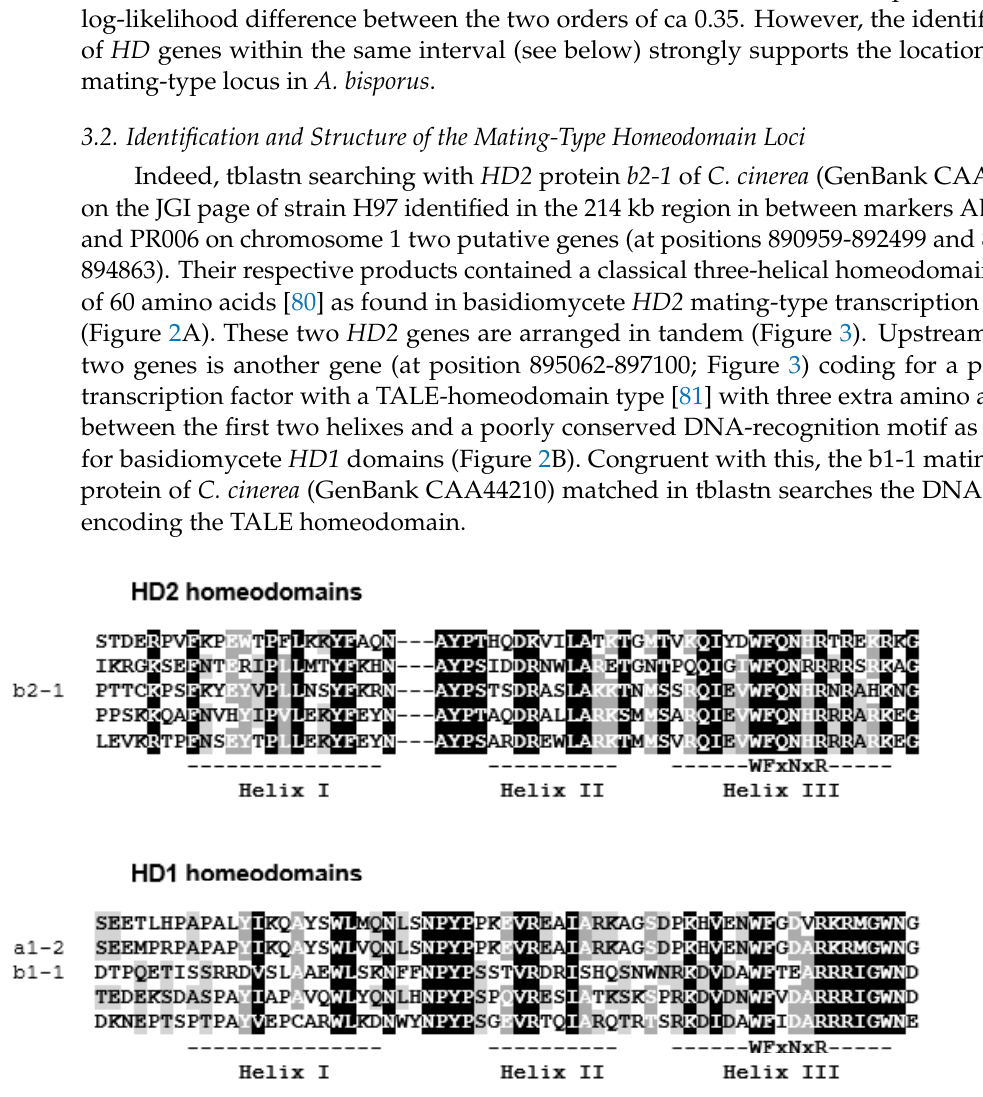
Figure 2. Sequence alignment of ( A ) HD2 and ( B ) HD1 homeodomain motifs of A. bisporus mating-type proteins compared to HD1 and HD2 mating type proteins of C. cinerea (GenBank EAU92789, CAA44210, CAA566131, CAA56132). Marked are the positions of the three helixes of the homeodomains and the conserved aa in the DNA-binding motif in Helix III (after [80]). Dashes in the HD2 sequences denote the position of insertion of the three extra amino-acid in the HD1